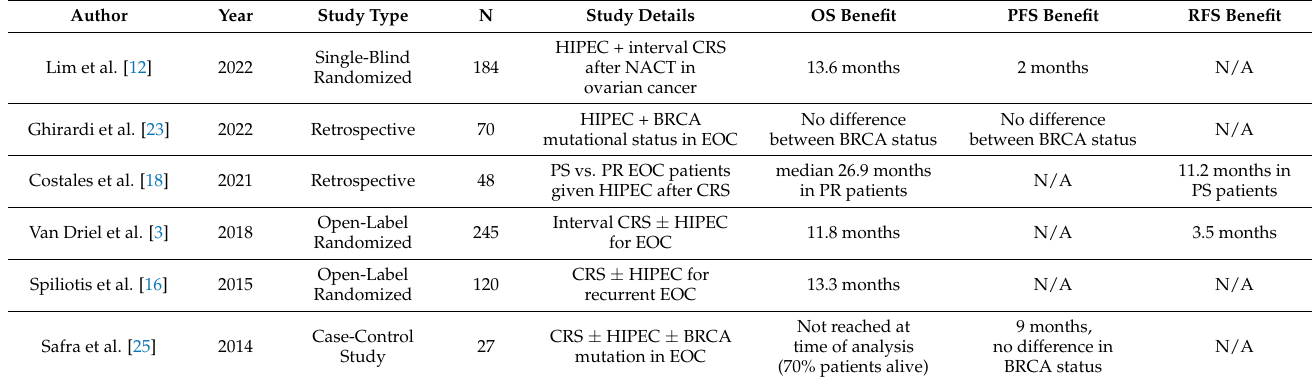
Table 1. Summary of clinical findings indicating HIPEC survival